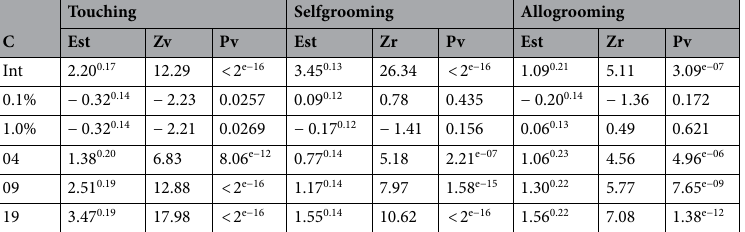
Table 1. Coefficients (C), intercept (Int.) and estimated values (Est.) (mean + standard error-SE), z.value (Zv) and Pr > z (Pv) of the generalized linear model of the touching, self-grooming and allogrooming frequencies between Atta sexdens rubropilosa (Hymenoptera: Formicidae) workers contaminated with quinone inside inhibitor fungicide at 0.1% (0.1%) and 1.0% (1.0%) with the proportions of 04, 09 and 19. Superscripted values are the standard error of the mean for groups.